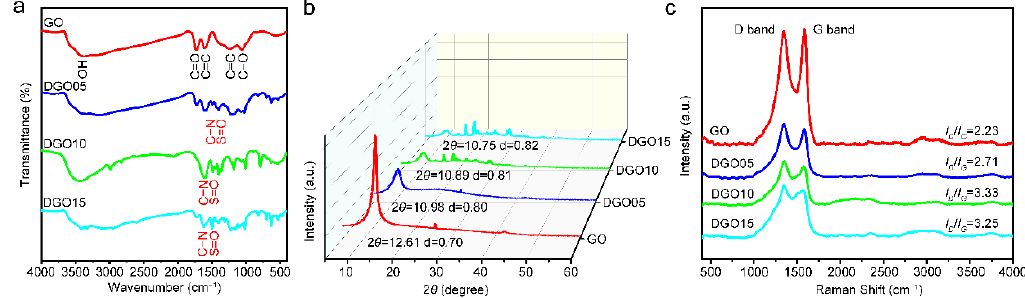
Figure 2. FT-IR spectra ( a ), XRD spectra ( b ) and Raman spectra ( c ) of GO, DGO05, DGO10 and DGO15.